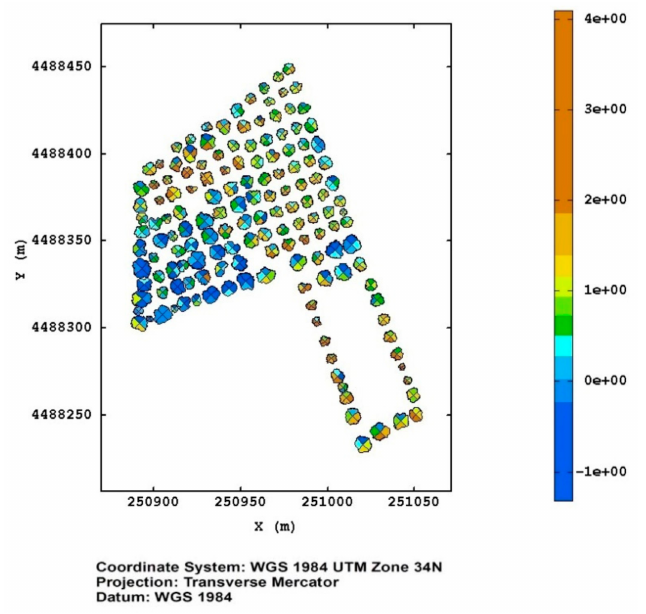
Figure 9. The map of the canonical variable for the Torchiarolo field on March 2018.